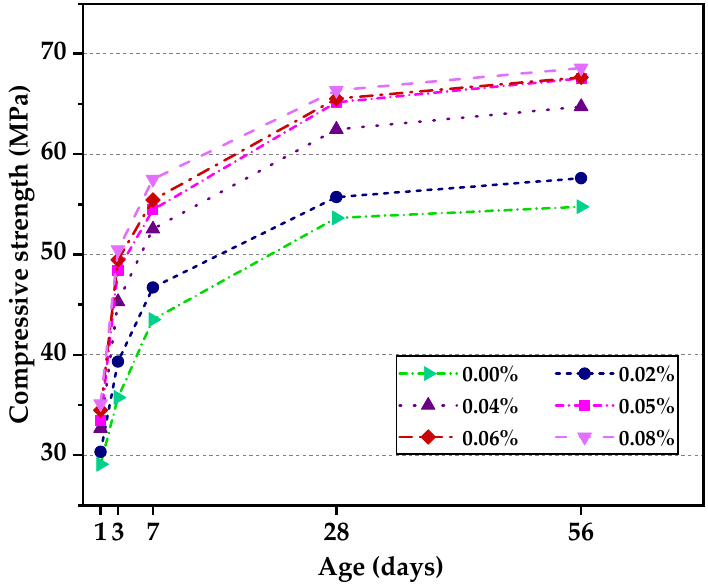
Figure 4. Compressive strength of concrete at different ages.